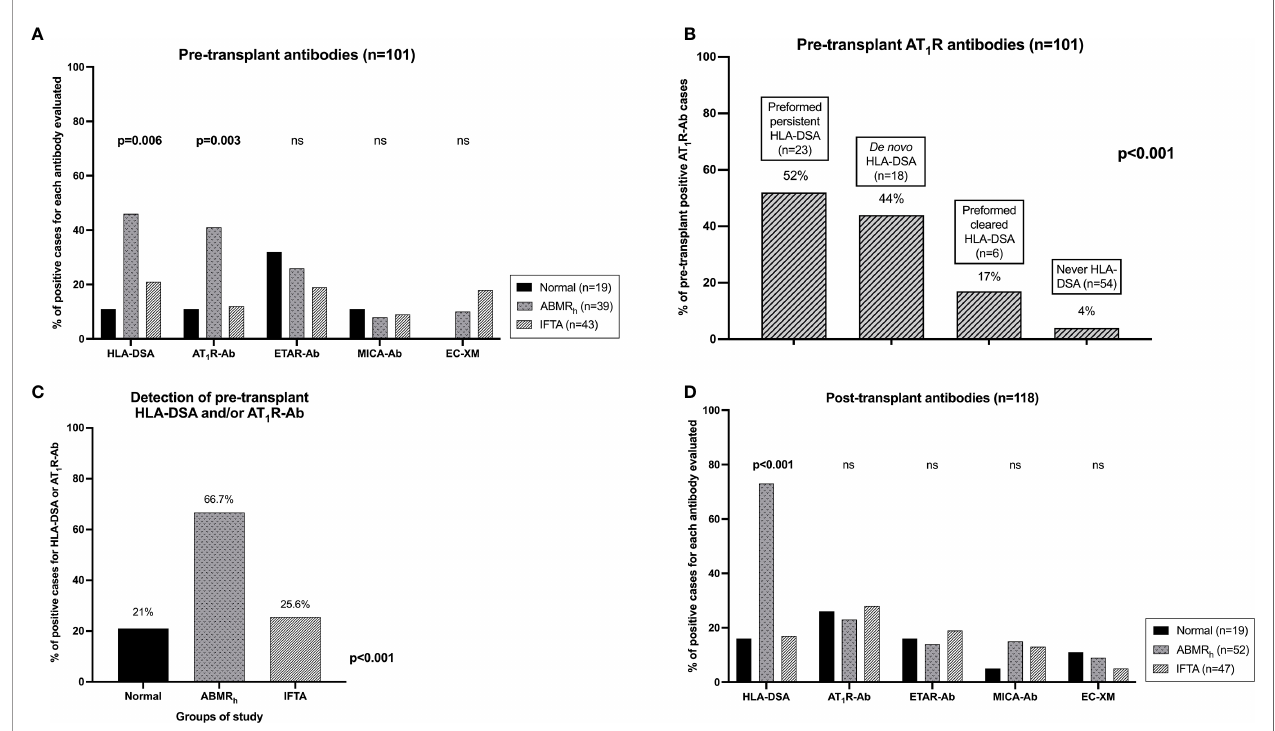
FIGURE 1 | Pre-transplant HLA and non-HLA antibodies. (A) HLA, AT 1 R-Ab, ETAR-Ab, MICA-Ab and EC-XM before transplantation in the three groups of study. (B) Pre-transplant AT 1 R-Ab positive and negative patients with preformed persistent HLA-DSA, preformed cleared HLA-DSA, de novo HLA-DSA or without HLA- DSA at any time. (C) Detection of pre-transplant HLA-DSA and/or AT 1 R-Ab in the three study groups. (D) Post-transplant HLA and non-HLA antibodies. HLA, AT 1 R- Ab, ETAR-Ab, MICA-Ab and EC-XM after transplantation in the three groups of study. ABMR h , antibody-mediated rejection histology; AT 1 R-Ab, antibodies against angiotensin II type 1 receptor; EC-XM, crossmatch with primary aortic endothelial cells; ETAR-Ab, antibodies against endothelin-1 type A receptor; IFTA, interstitial fi brosis and tubular atrophy; KT, kidney transplantation; MICA-Ab, antibodies against major histocompatibility complex class I related chain A. ns, non-signi fi